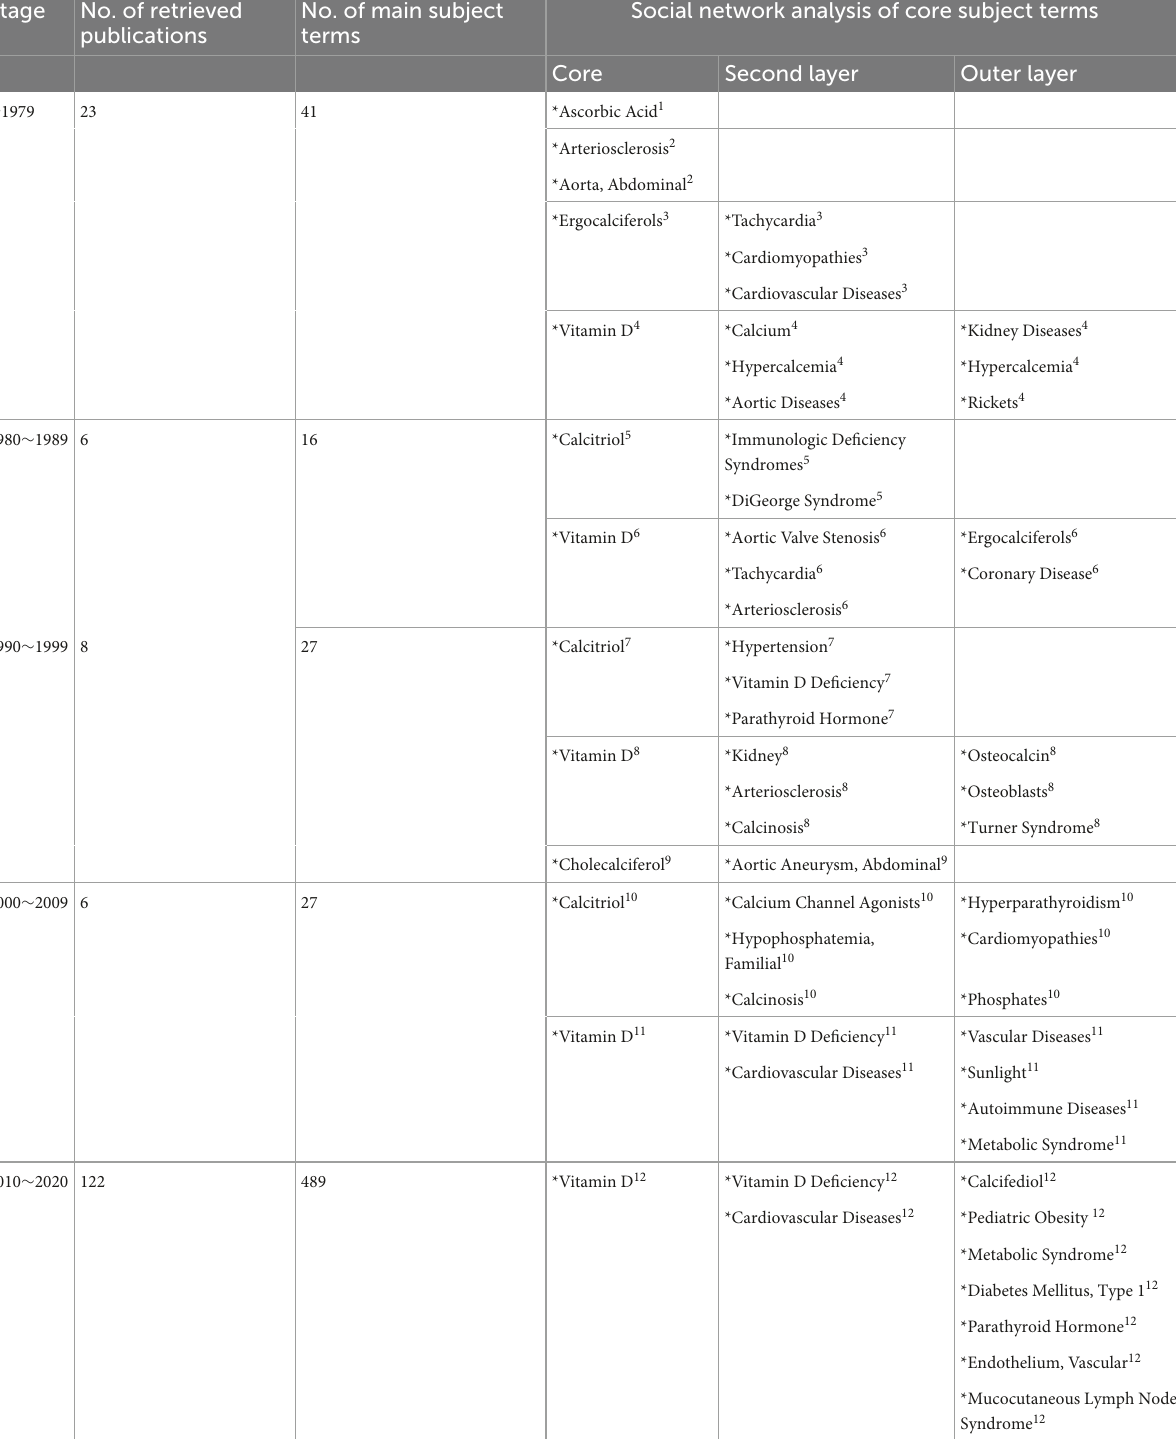
TABLE 2 Literature analysis of “vitamin D AND cardiovascular disease (0–18 years)” in PubMed as of December 2020.